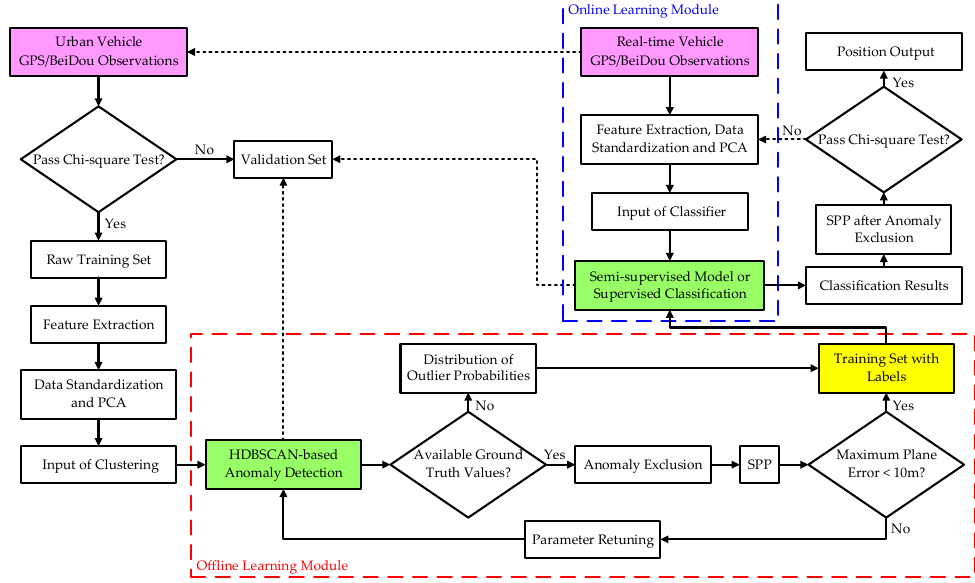
Figure 1. The hybrid learning framework flow diagram for global navigation satellite systems (GNSS) observation anomaly detection.